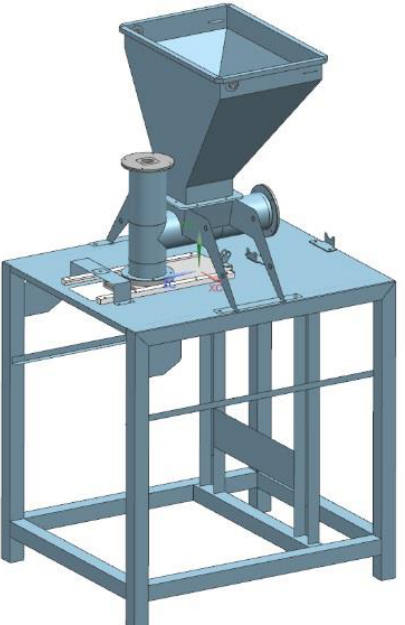
Figure 2. Plate-shell model of a forming module with solid